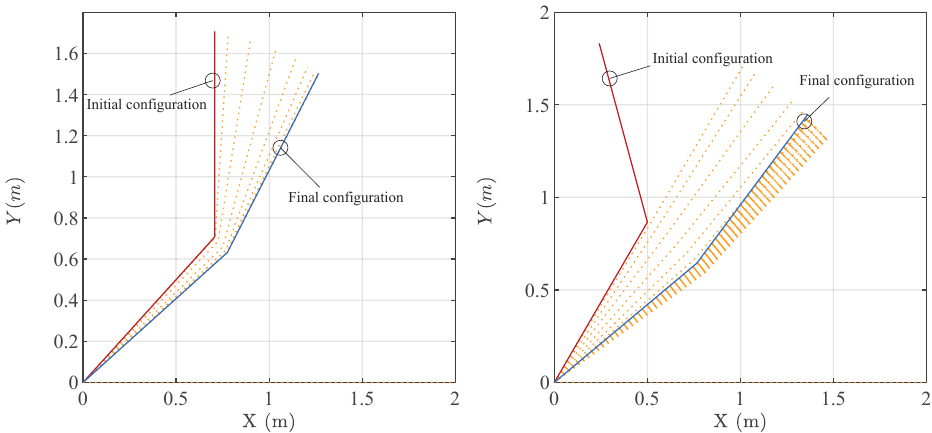
Figure 17. Task performances of the master and slave robots with the method in Case 3.